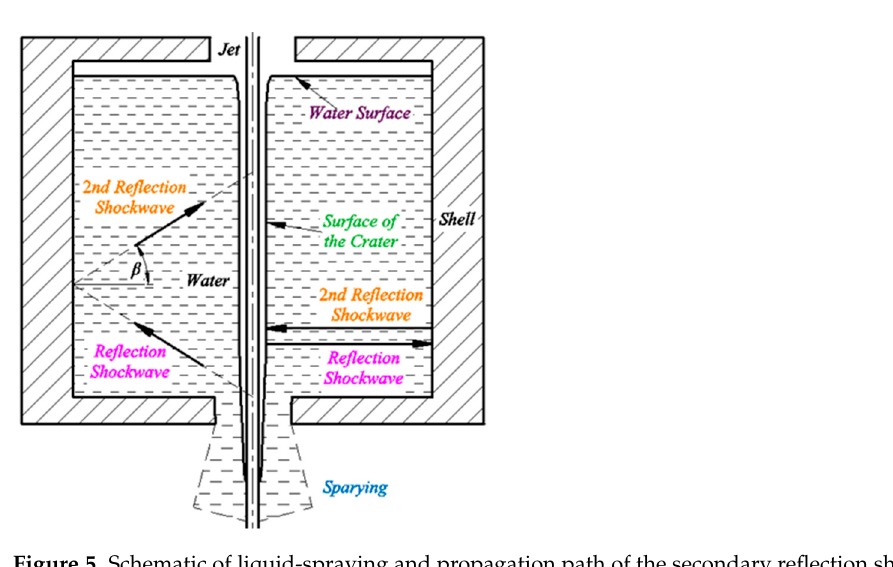
Figure 5. Schematic of liquid-spraying and propagation path of the secondary reflection shock wave.